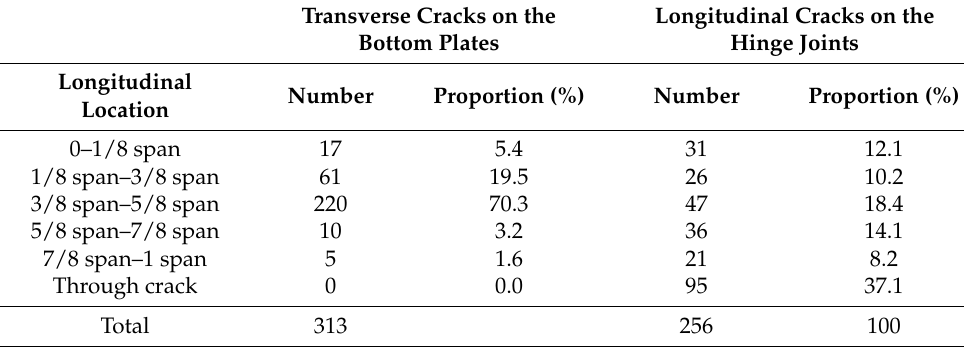
The dimension distribution of two kinds of cracks is shown in Table 7. Most of the crack length and width of the transverse cracks on the bottom plates of the girders is within increases from 0.2 to 0.5 m or when the crack width increases from 0.2 to 0.5 mm. For the